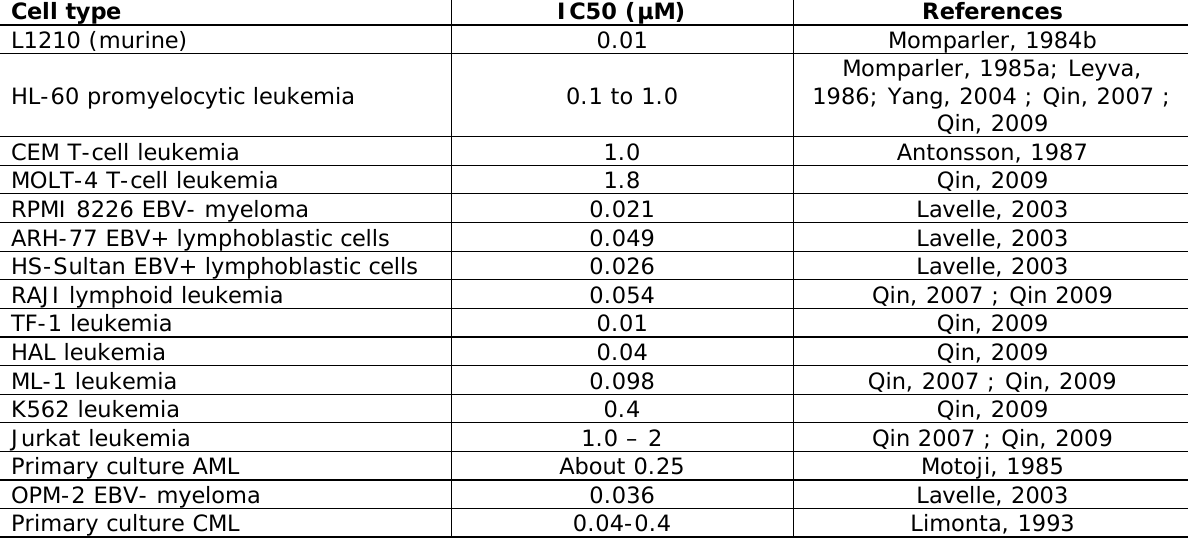
Table 1: In vitro activity of decitabine against animal and human tumor